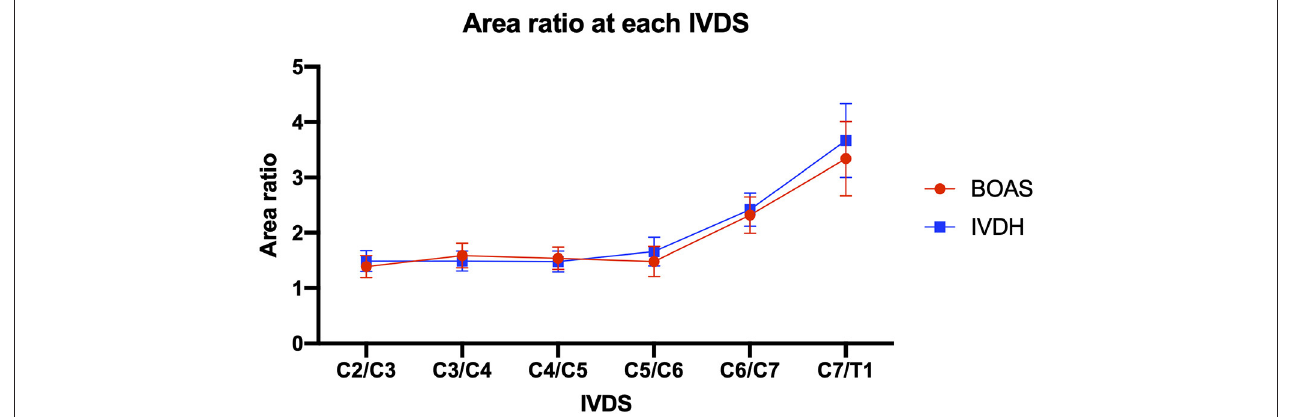
FIGURE 8 | Line graph showing dorsal-to-ventral mean area ratio of cervical paraspinal musculature in IVDS from C2/C3 to C7/T1 in French bulldogs of the BOAS group (red line) and the IVDH group (blue line).